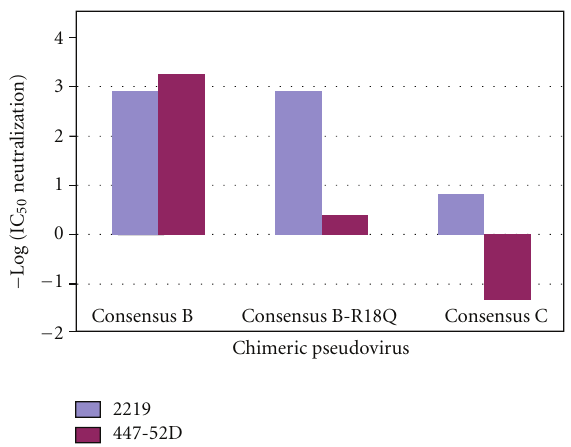
Figure 1: Neutralization of chimeric psVs by antibodies 447-52D (purple) and 2219 (blue). The psV consist of the SF162 strain with its V3 loop replaced by the indicated V3 loop sequence. Consensus B-R18Q is a psV consisting of the consensus subtype B V3 loop sequence with position 18 in the V3 loop mutated from a subtype B consensus arginine to a subtype C consensus glutamine. IC 50 is the amount of antibody in ug/mL required to achieve 50% neutral- ization. The negative base 10 logarithm of the IC 50 has been plotted for easier comparison: higher, positive bars towards the top of the graph indicate strong neutralization by the antibody. Antibodies were only tested to a concentration of 20 ug/mL for neutralization, so the negative value of 1.3 on the plot is maximal and indicated no detectable neutralization by the antibody. Adapted from